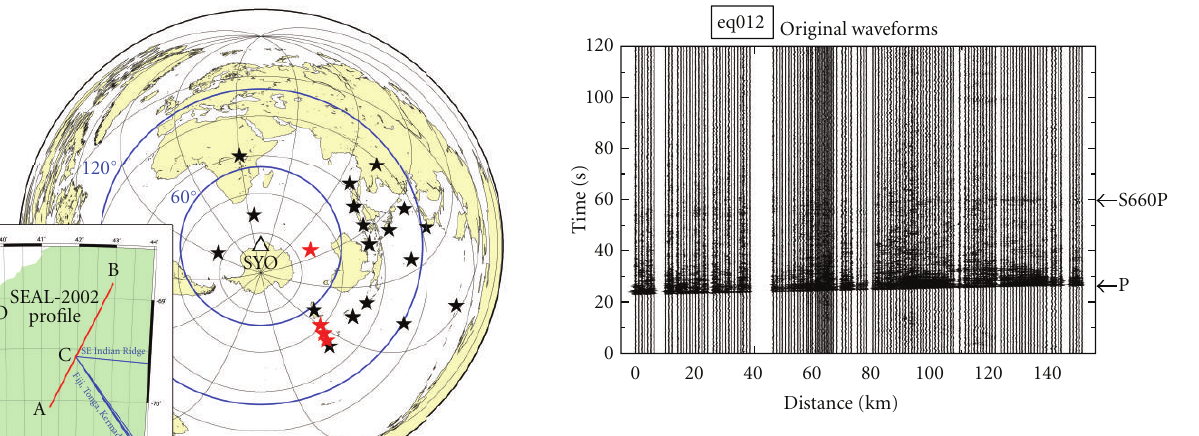
Figure 6: Record section indicating a typical teleseismic event occurred at Kermadec Is. (m b = 4 . 5,Depth = 437km; event#; eq012; modified after [23]). The vertical axis is the relative time measured from 14:01:30.0 (UTC) on January 21, 2002. Original (no filtered) traces for all station along the profile represent high signal- to-noise ratio. Very strong signals during 20–30 s are composed of direct P and possibly reverberations from the ice-sheet. Faint signals found in 50–60 s may be an S-P converted wave at the 660 km discontinuity just beneath the event